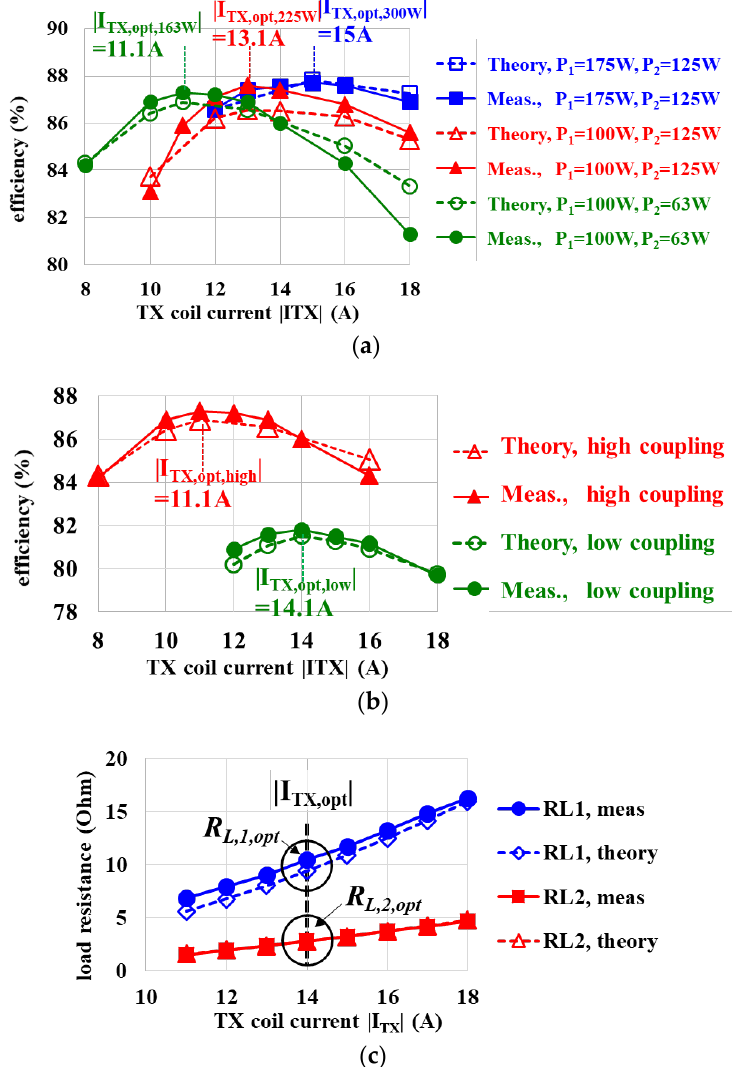
Figure 4. | I TX | sweeps while load power is regulated to required level. Theory agrees well with measurement. ( a ) The calculated optimum | I TX,opt | of (7) coincide with the measured | I TX | across different load powers. For constant M 1 = 4 .23 μH and M 2 = 2 .87 μH. ( b ) The calculated optimum | I TX,opt | of (7) coincide with the measured | I TX |. High coupling: M 1 = 4 .23 μH and M 2 = 2 .87 μH. Low